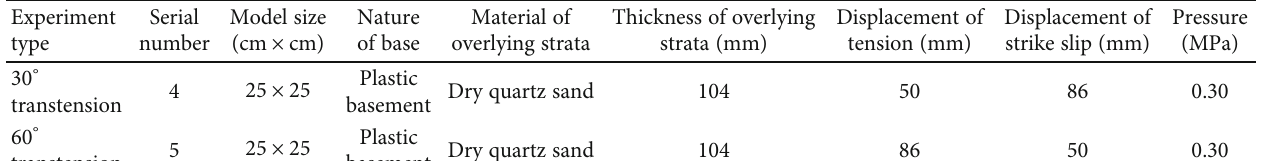
Figure 7: Formation simulation of mud diapir under the background of strike slip. (a) Plane photo of the strike-slip formation model; (b) completion of strike slip, symmetrical fracture of the model; (c) after injection of fl uid, mound-like uplift appeared on the model surface, and the formation was punctured and fractured; (d) cross section in the center of the model, formation fault could be seen, but only a slight diapir activity was observed, and the scale of diapir was much smaller than that of experiment 2. Table 5: Experimental parameters and record results of the transtension group.